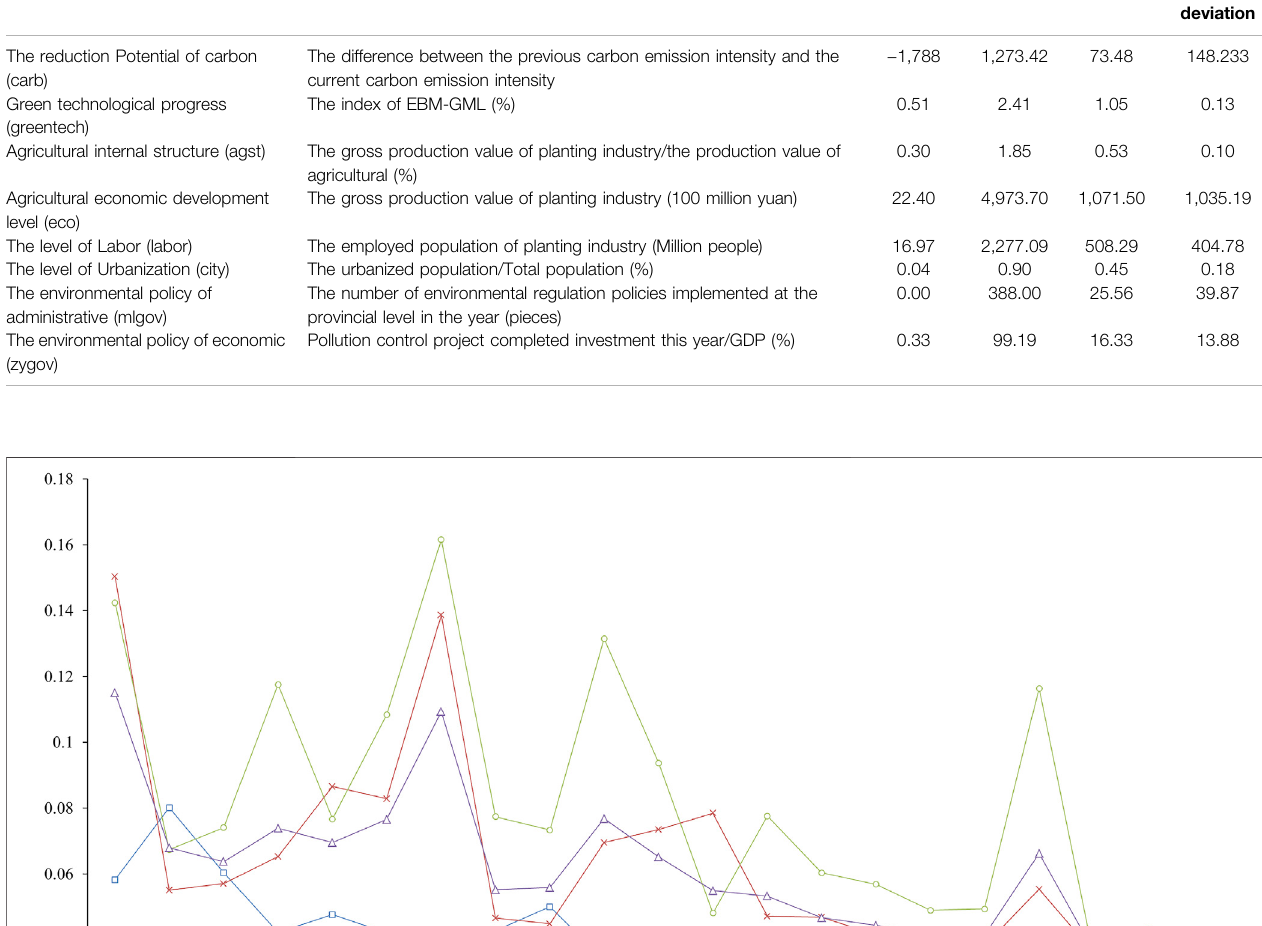
Frontiers in Energy Research |